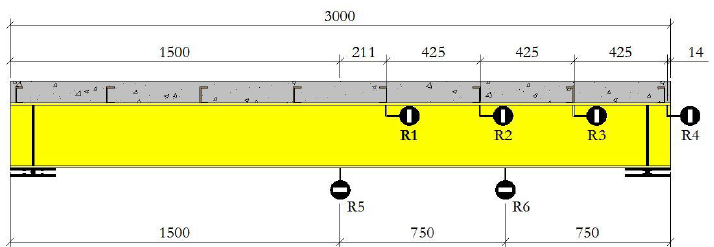
Figure 10. Positioning of the meter